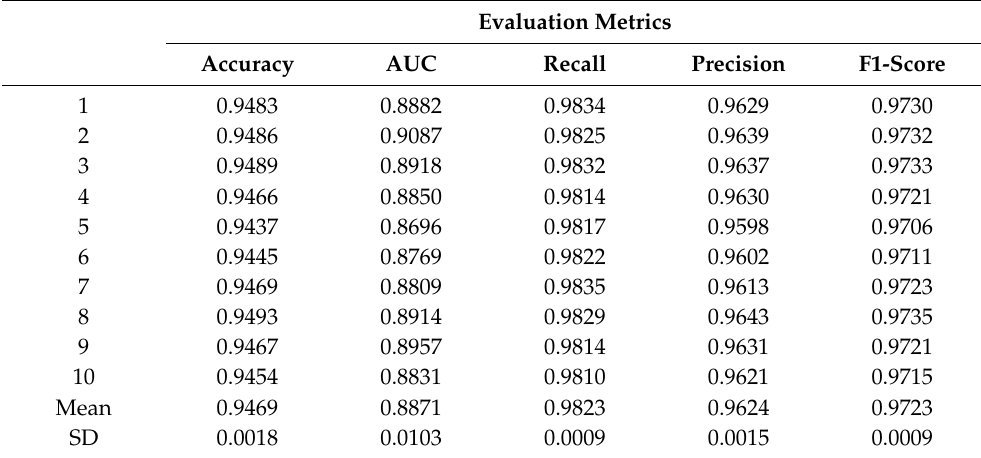
Table 7. The 10-fold cross-validation results for GBDT.